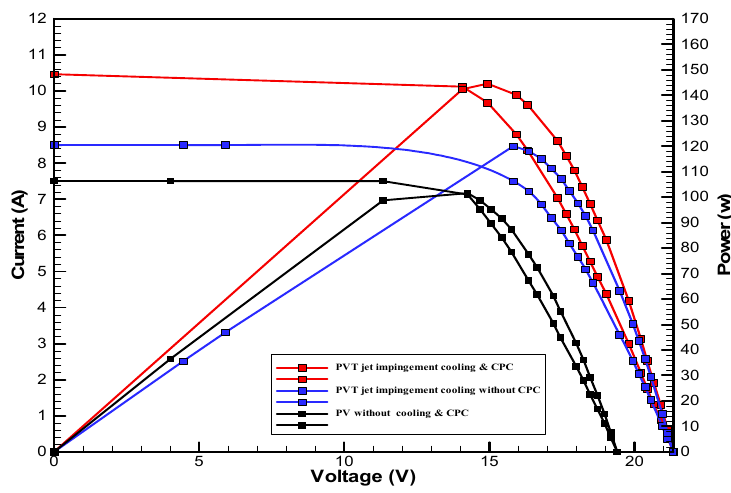
Figure 18. The I-V-P characteristic curve of the PV module in compared systems; PVT with CPC, PVT without CPC and PV free without CPC at Solar radiation 1000 w/m 2 .